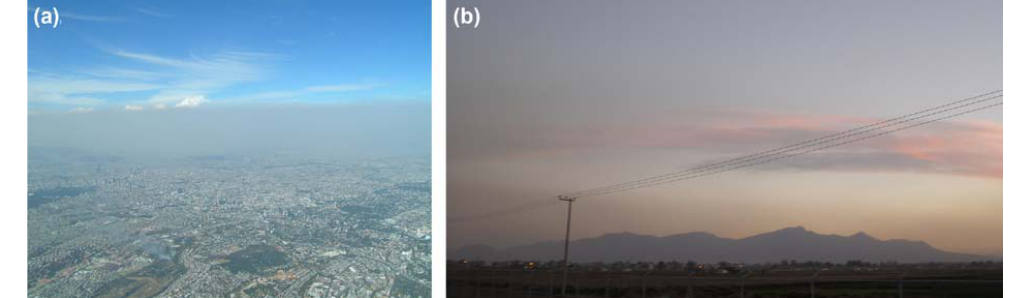
Fig. 6. (a) Air pollution obscures the entire north side of Mexico City in this photograph taken from the C-130 in the late afternoon of 18 March. The CMET balloons were launched at 22:30 UTC (the time of the photo) and 1.5h later at 00:00 UTC (19 March) from a site in the background near the left edge of the image. Photo credit: S. Madronich. (b) The Sierra de Guadalupe mountain range near the center of the Mexico City was still enveloped in a polluted layer up to 1.5km deep when this photograph was taken looking southeast at approximately 01:00 UTC (19 March).